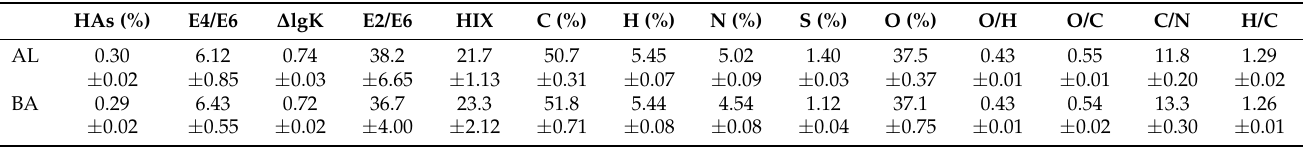
Table 1. The content, structural, and chemical properties of humic acids (HAs) from Abruptic Luvisol (AL) and Brunic Arenosol (BA) untreated soils at the start of the field experiment. The table shows mean values ± standard deviation. HAs